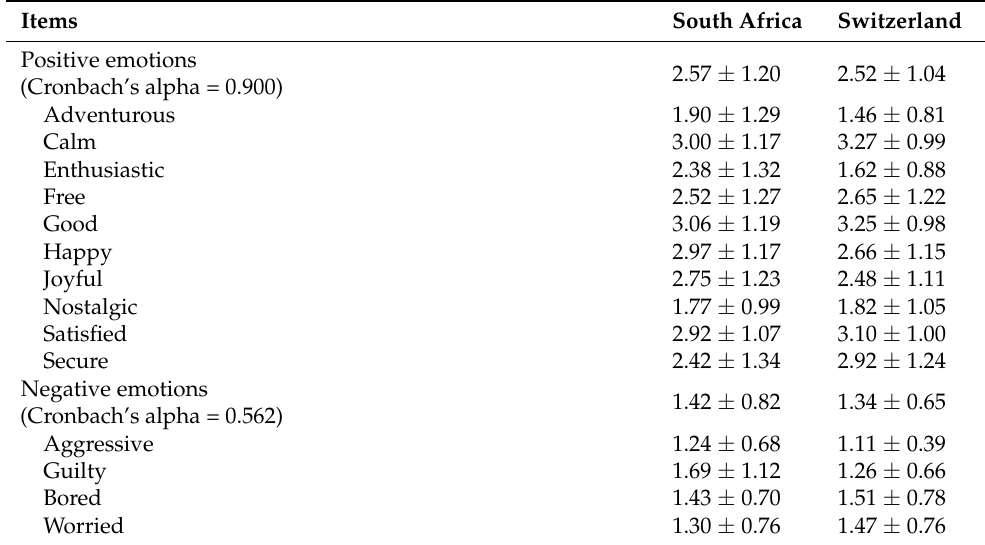
Table 3. Mean and standard deviation (m ± sd) values of consumers’ emotions after biscuit